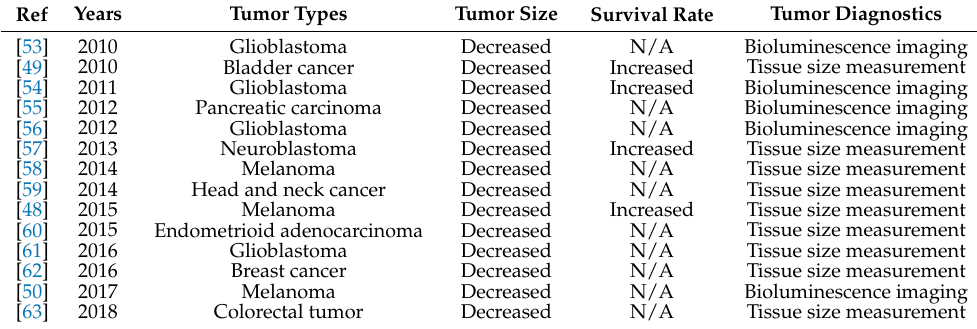
Table 2. Representative in vivo demonstrations on subcutaneous xenografted tumor models